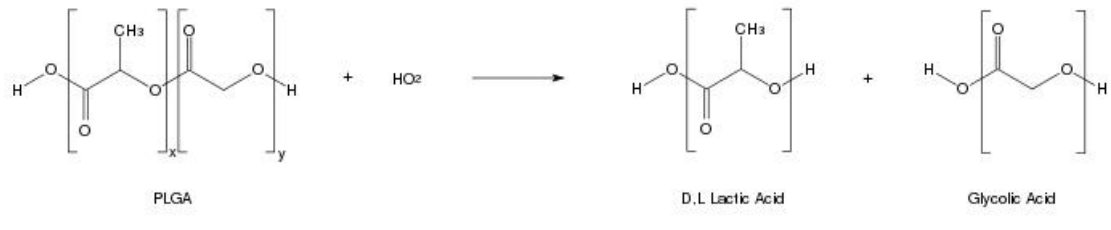
Figure 2. Hydrolysis of poly lactic- co -glycolic